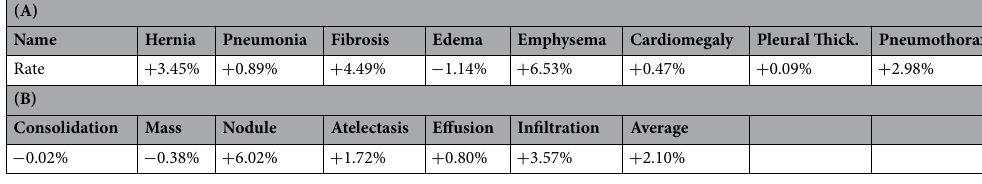
Table 9. The improvement